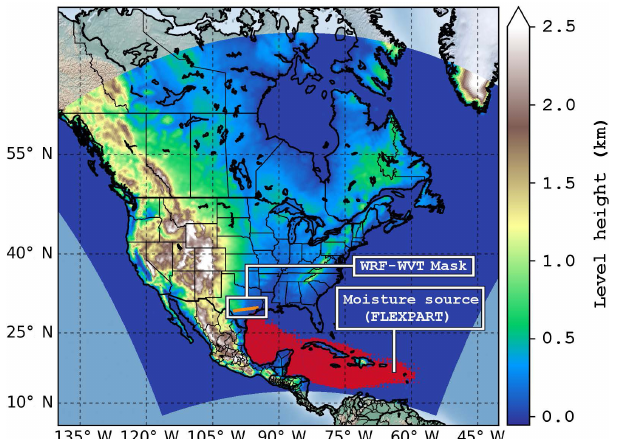
Figure 2. Highlighted in red are moisture sources obtained with FLEXPART from backward trajectories originating in the region outlined in magenta in Fig. 1a. The orange line over the continent marks the position from where precipitable water is tagged in WRF- WVT, corresponding to the northern edge of the FLEXPART source region. All water vapour and condensate crossing through that line is considered as moisture advected by the GPLLJ for further analy-